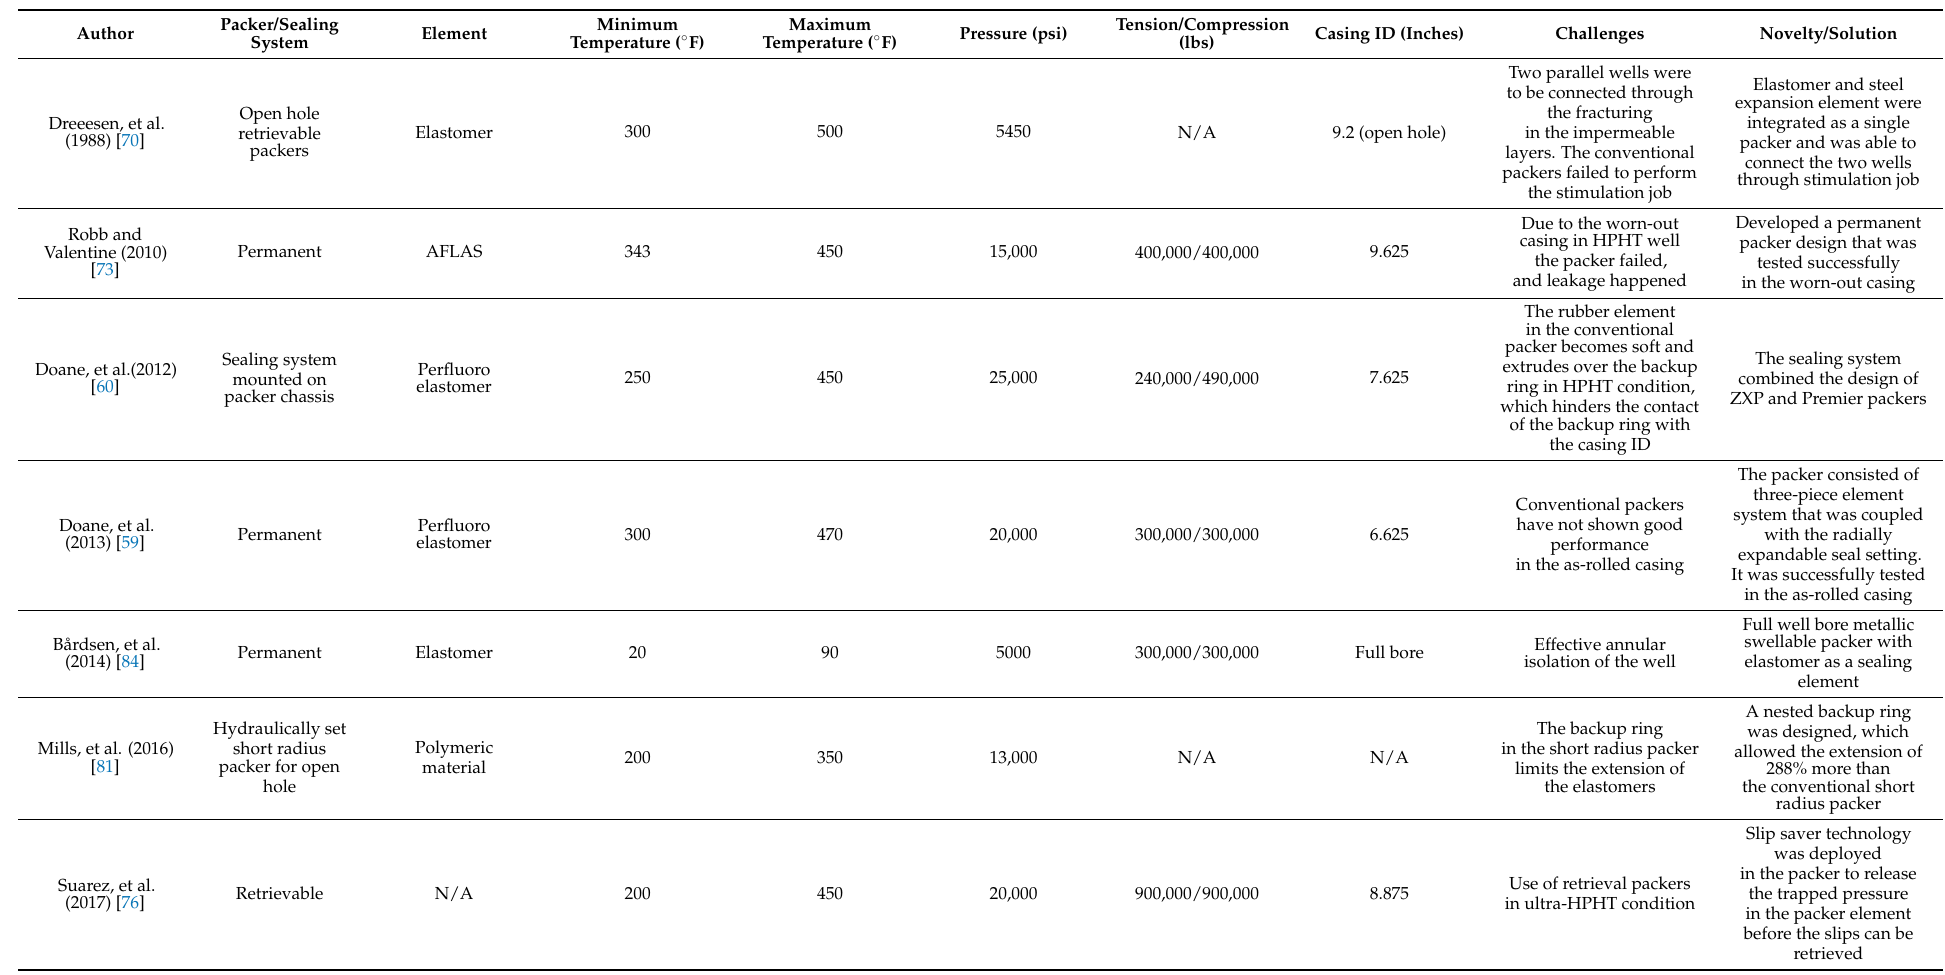
Table 8. Summary of the designed HPHT packers and sealing